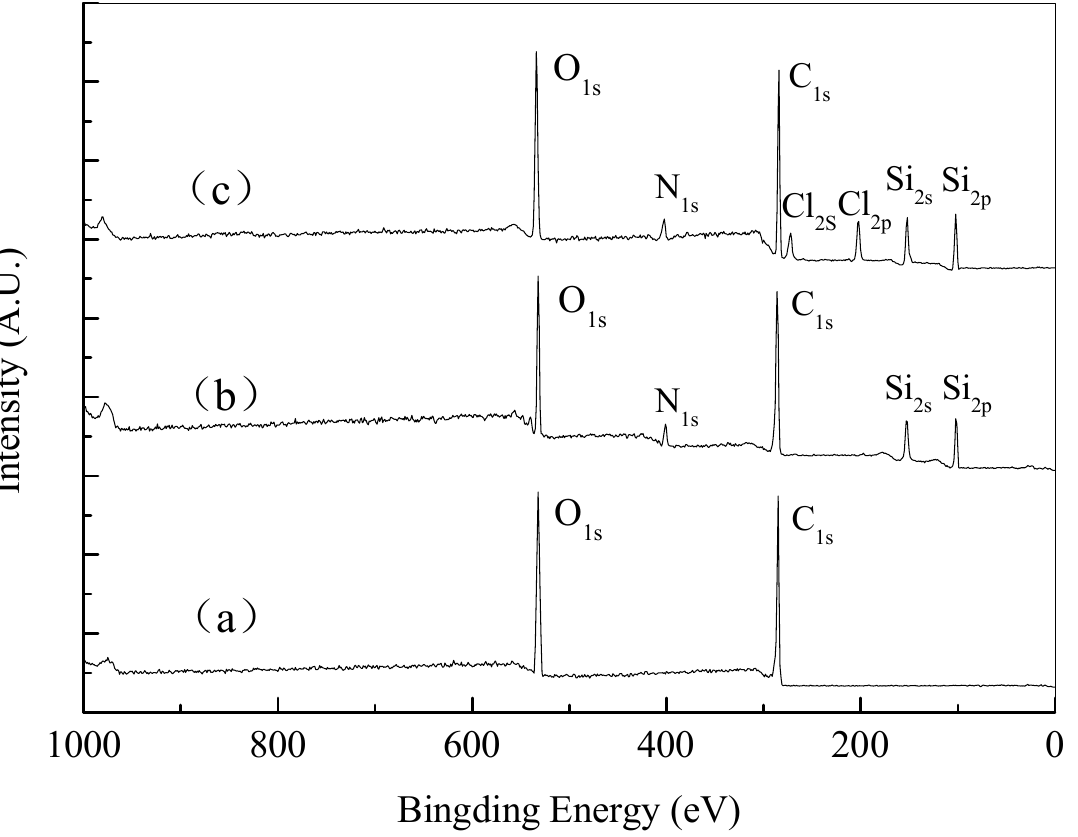
Figure 4. XPS wide scans of pristine cellulose ( a ), barbituric acid-based polysiloxane@cellulose ( b ), and cyclic imide N -halamine polysiloxane@cellulose ( c ).